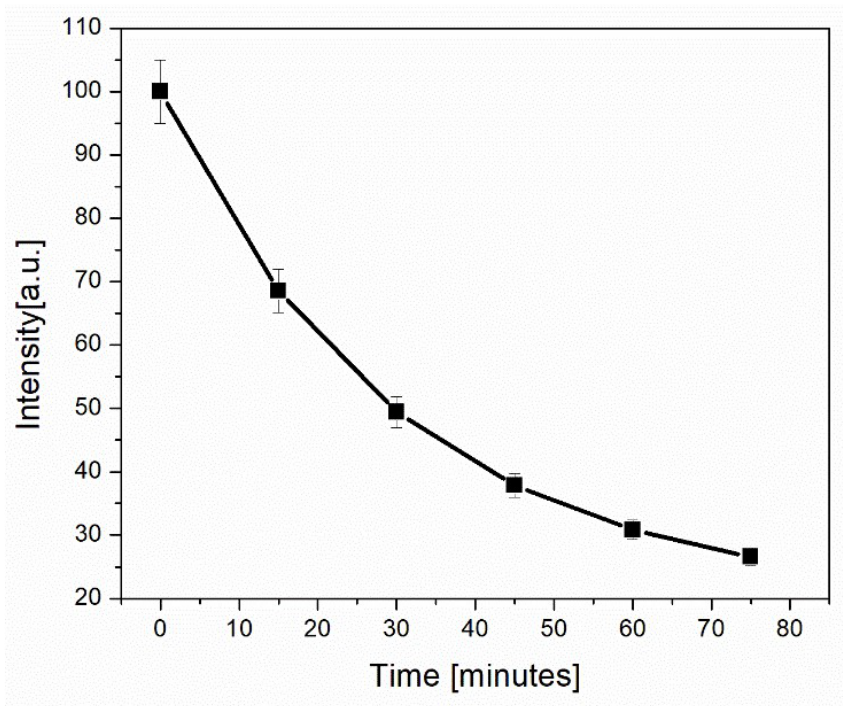
Figure 11. Intensity changes of TEMPO during incubation with yeast cells: experimental data ( ■ ), curve simulated according to Equation (2) (—), where C = 100 a.u. at the beginning of incubation, K1 = 0.8 a.u./min, τ 1 = 2 min, and τ 2 = 0.005 min. Changes in the intensity of the spin probes in the incubation process of yeast cells were approximated (Figure 11) according to Equation (2). The values of K1, τ1, and τ2 indicate the most significant dynamics of the spin probe disappearance inside cells (τ2 = 0.005 min). After 75 min of incubation of TEMPO and yeast cell suspension, approximately 80% of the spin-probe molecules entered the cells. The relaxation time τ1 (2 min) indicates a very effective attachment of TEMPO to cells, while K1 (0.8 a.u./min) confirms the high efficiency of endocytosis in the experiment dis- cussed.